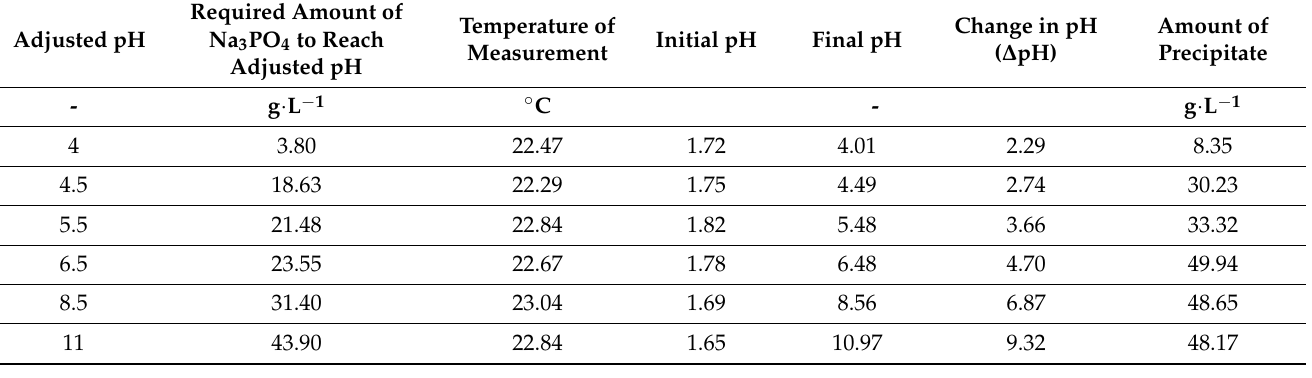
Table 7. Conditions of pH and amount of Na 3 PO 4 during precipitation of zinc and manganese from solution after selective leaching.